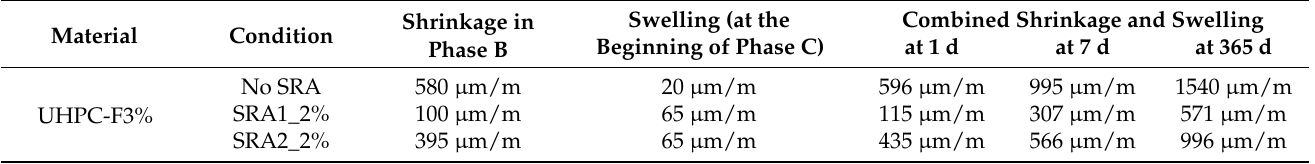
Figure 6. Shrinkage of UHPC-F3% with and without SRA, ( a ) early-age shrinkage, ( b ) long-term shrinkage. Table 4. Effect of SRA on the shrinkage and swelling of